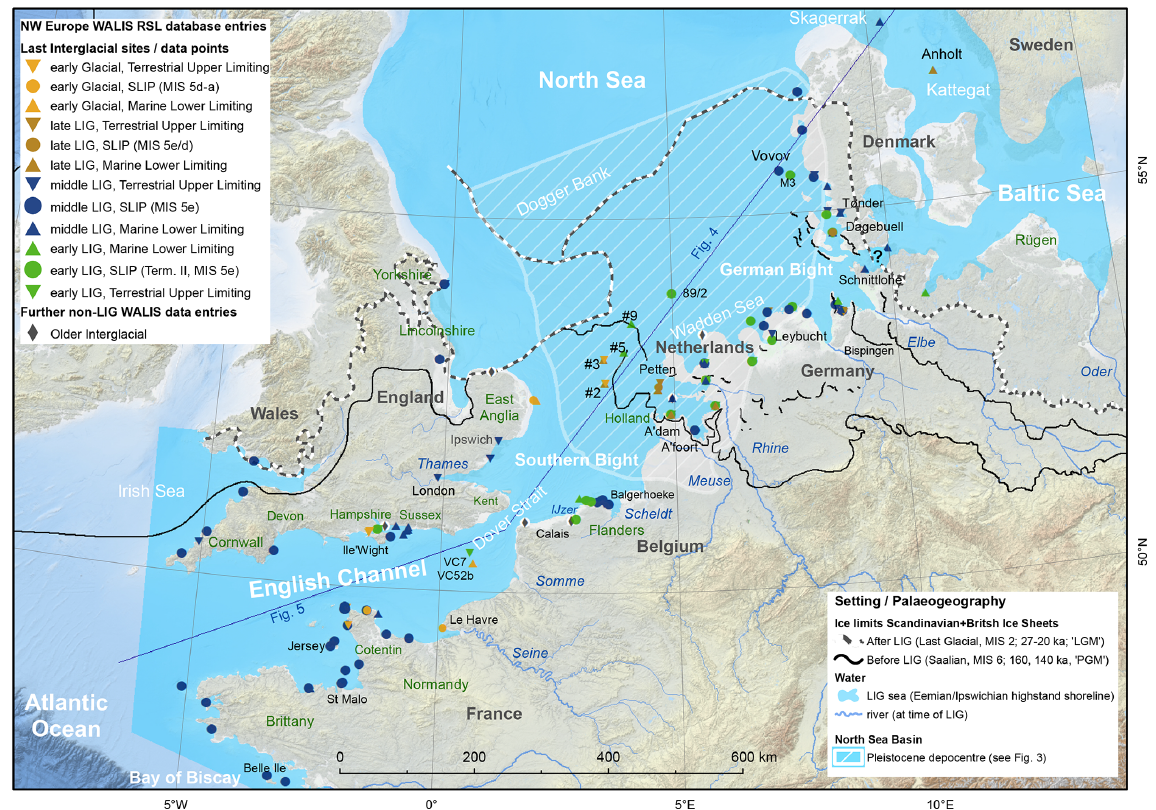
Figure 1. Overview of study area (Northwest Europe) with data points (legend groups; cf. Sect. 2) showing location of all data points entered into WALIS as part of this work. Penultimate (Saalian, MIS 6, PGM) and Last Glacial maximum (LGM) ice limits compiled from regional studies (Ehlers et al., 2004; Busschers et al., 2008; Moreau et al., 2012; Lang et al., 2018; Gibbard et al., 2018; Cartelle et al., 2021) and adjoining super-regional overviews (Ehlers and Gibbard, 2004; Batchelor et al., 2019). Pleistocene depocentre in the North Sea further detailed in Sect. 3.3. Axis through North Sea and English Channel informs the presentation of data in Figs. 4 and 5. Selection of topographic names from text included, offshore sites with informal short IDs from source papers. Bathymetry and DEM backdrop: WMS service of EMODnet Bathymetry Consortium (2020), which incorporates land data © OpenStreetMap contributors 2020. Distributed under the Open Data Commons Open Database License (ODbL)